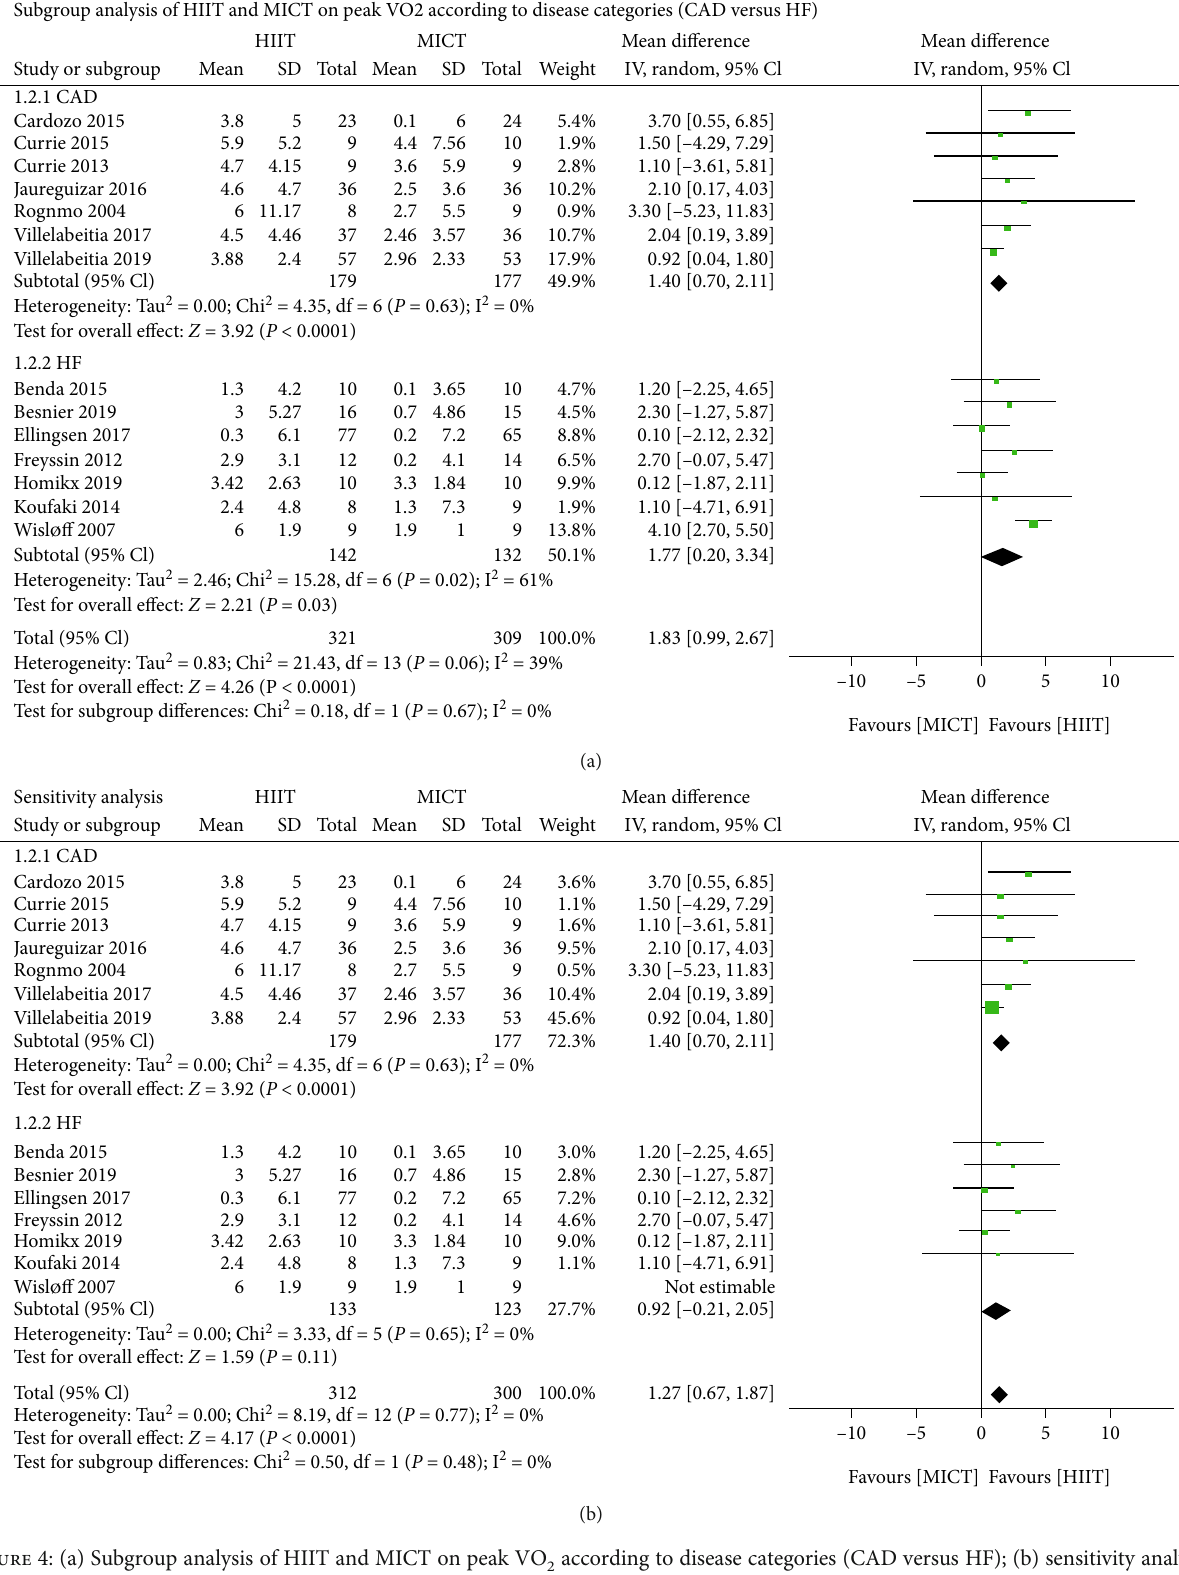
Figure 4: (a) Subgroup analysis of HIIT and MICT on peak VO HIIT: high-intensity interval training; MICT: moderate-intensity continuous training; peak VO artery disease; HF: heart failure; SD: standard deviation; CI: con fi dence